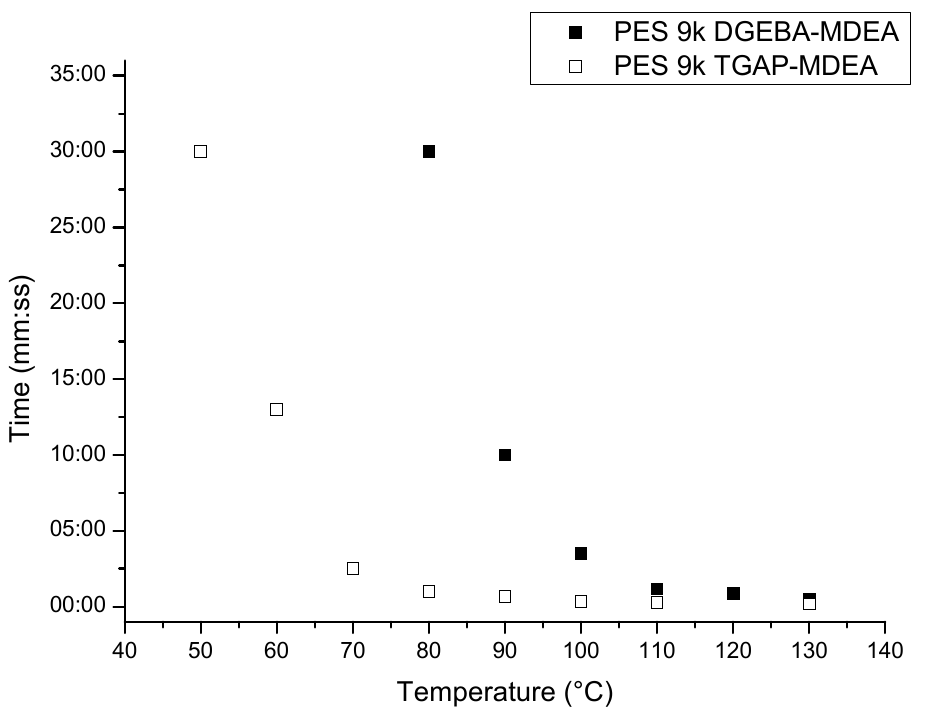
Figure 2. Dissolution time at different temperatures for coPES 9k in DGEBA-MDEA (data from [7]) and in TGAP-MDEA.